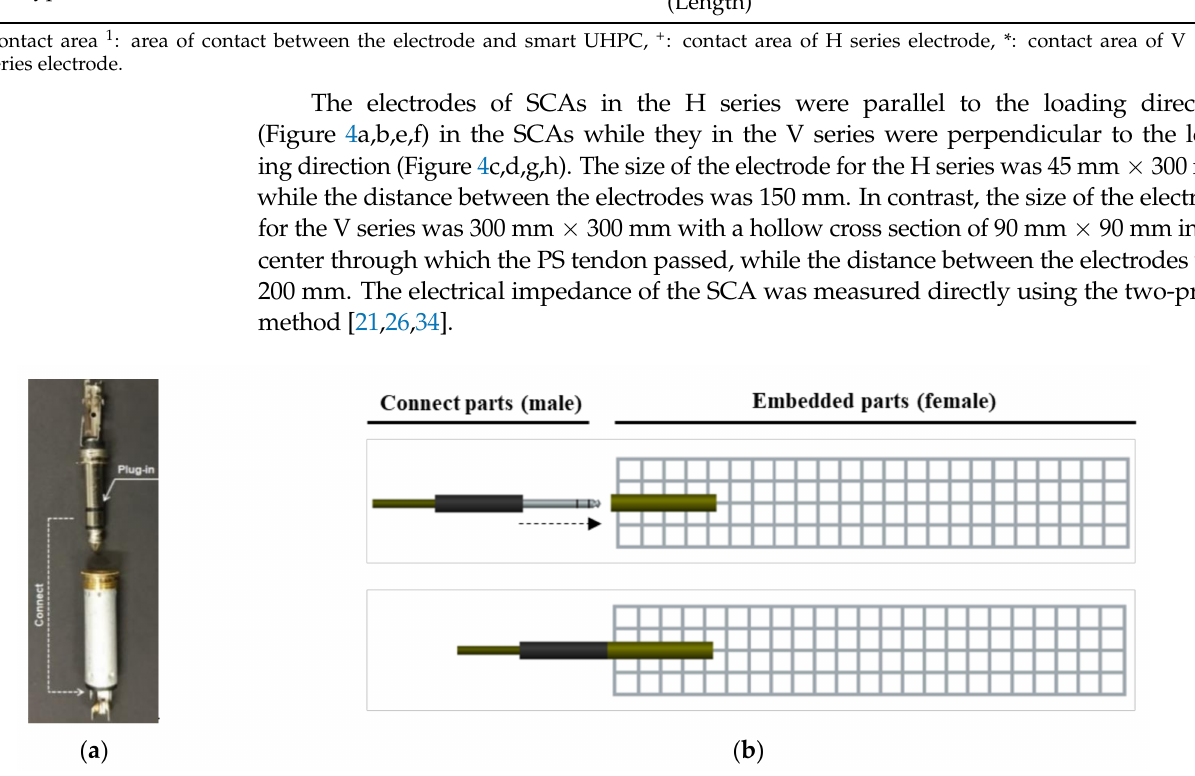
Figure 5. Connector and connect method: ( a ) plug-in stereo; ( b ) connect part (male)/embedded parts (female).